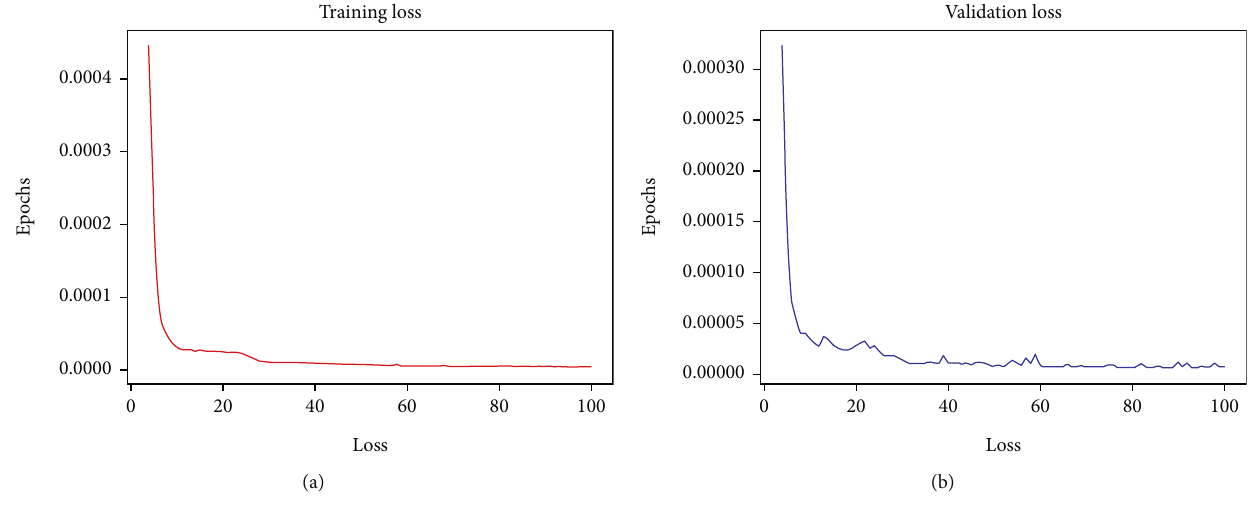
Figure 9: Training and validation loss in 100